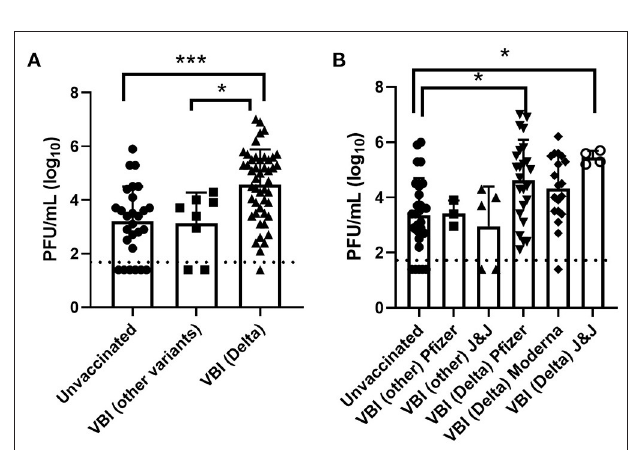
FIGURE 2 | Infectious virus titers in unvaccinated and vaccinated personnel. (A) Viral titers in nasal swabs determined by standard plaque assay, (B) viral titers broken down by vaccine type. Error bars represent the standard deviation, and the dashed line represents the detection limit of the plaque assay. Symbols below this line were negative by the plaque assay, but positive by the CPE assay. Asterisks indicate statistical significance determined by Tukey’s multiple comparisons